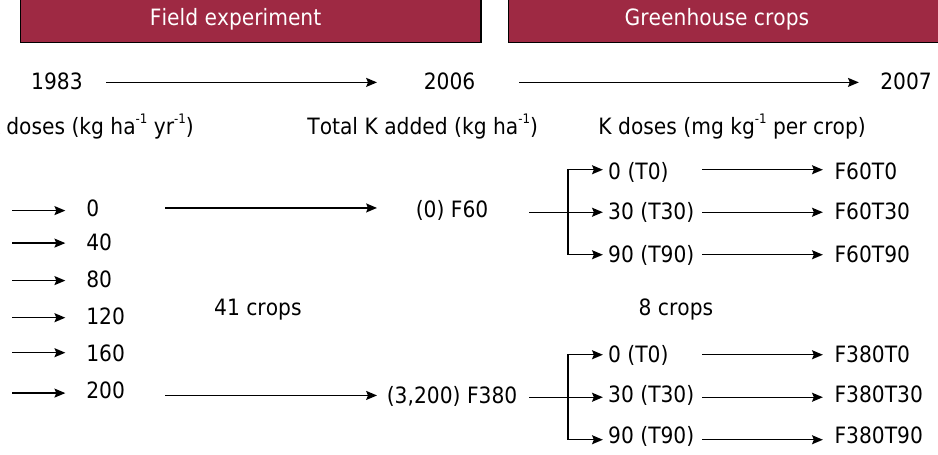
Figure 1. Experimental design of the field and greenhouse K experiments regarding the K contents added to a Ferralsol from Paraná,